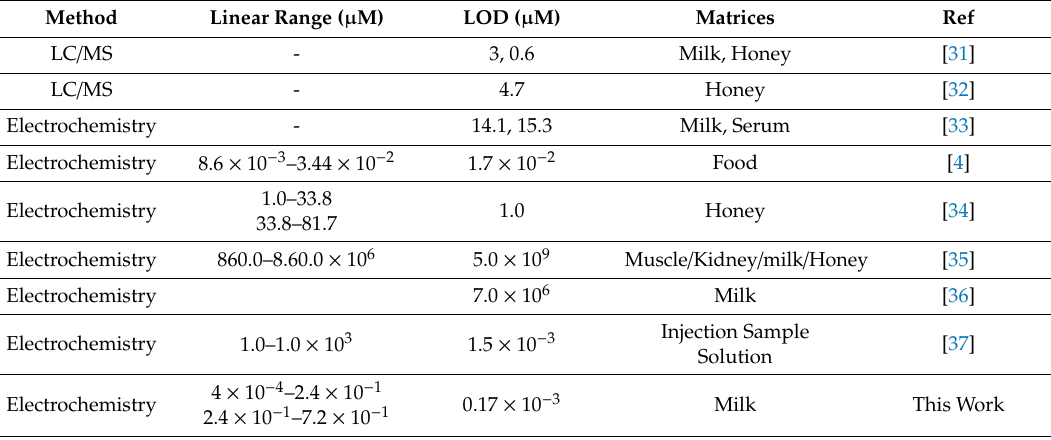
Table 1. Comparison of the present method with other analytical